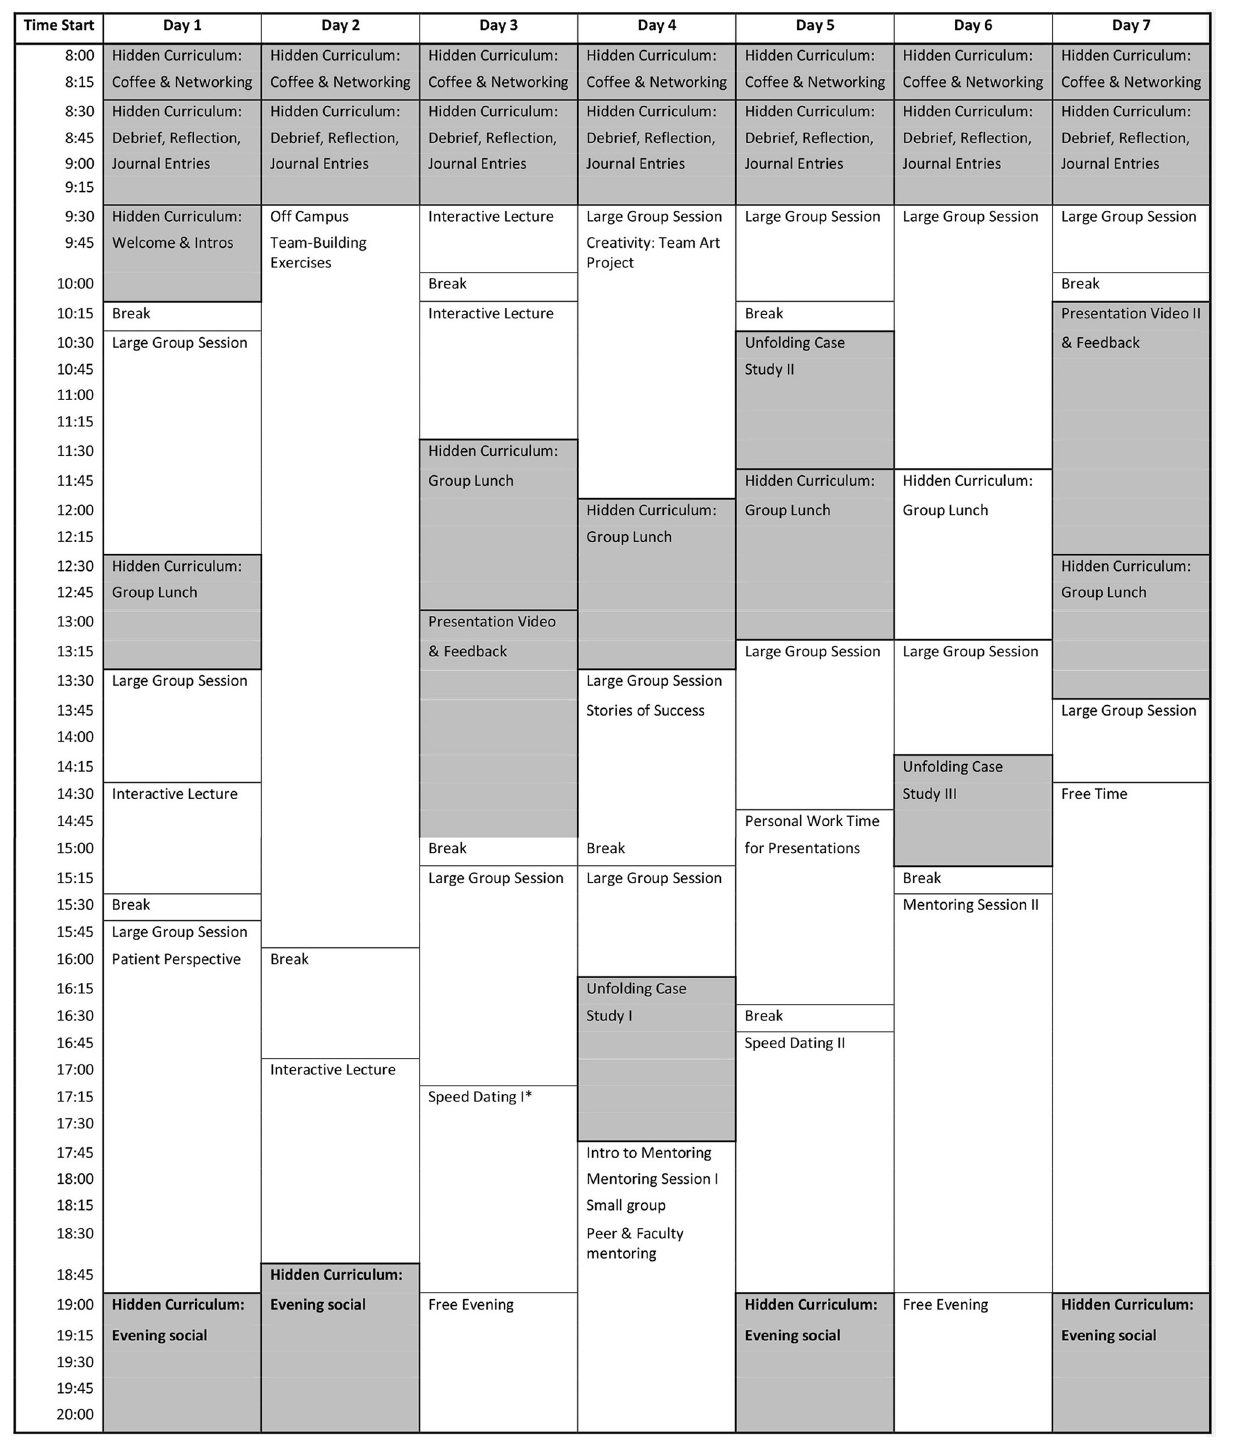
Frontiers in Public Health | www.frontiersin.org